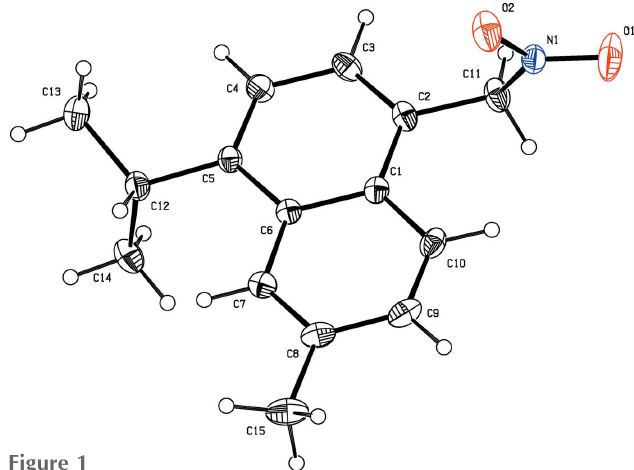
Figure 1 The molecular structure of the title compound, showing the atom labelling. Displacement ellipsoids are drawn at the 30% probability